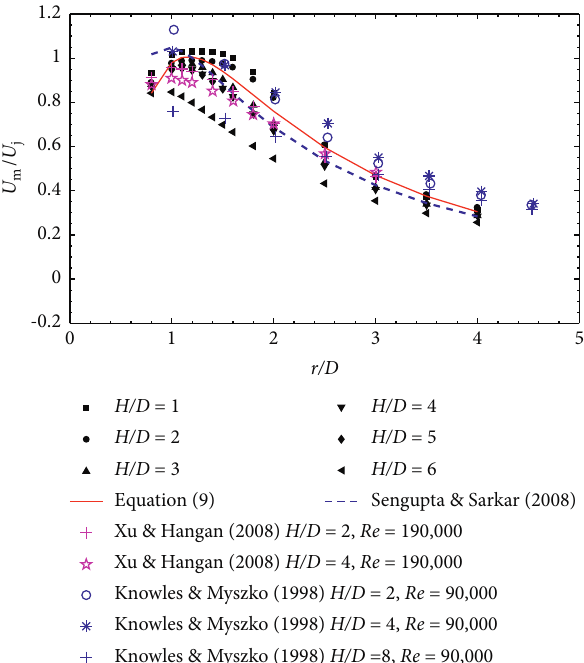
Figure 20: Decay of maximum mean radial velocity for different nozzle